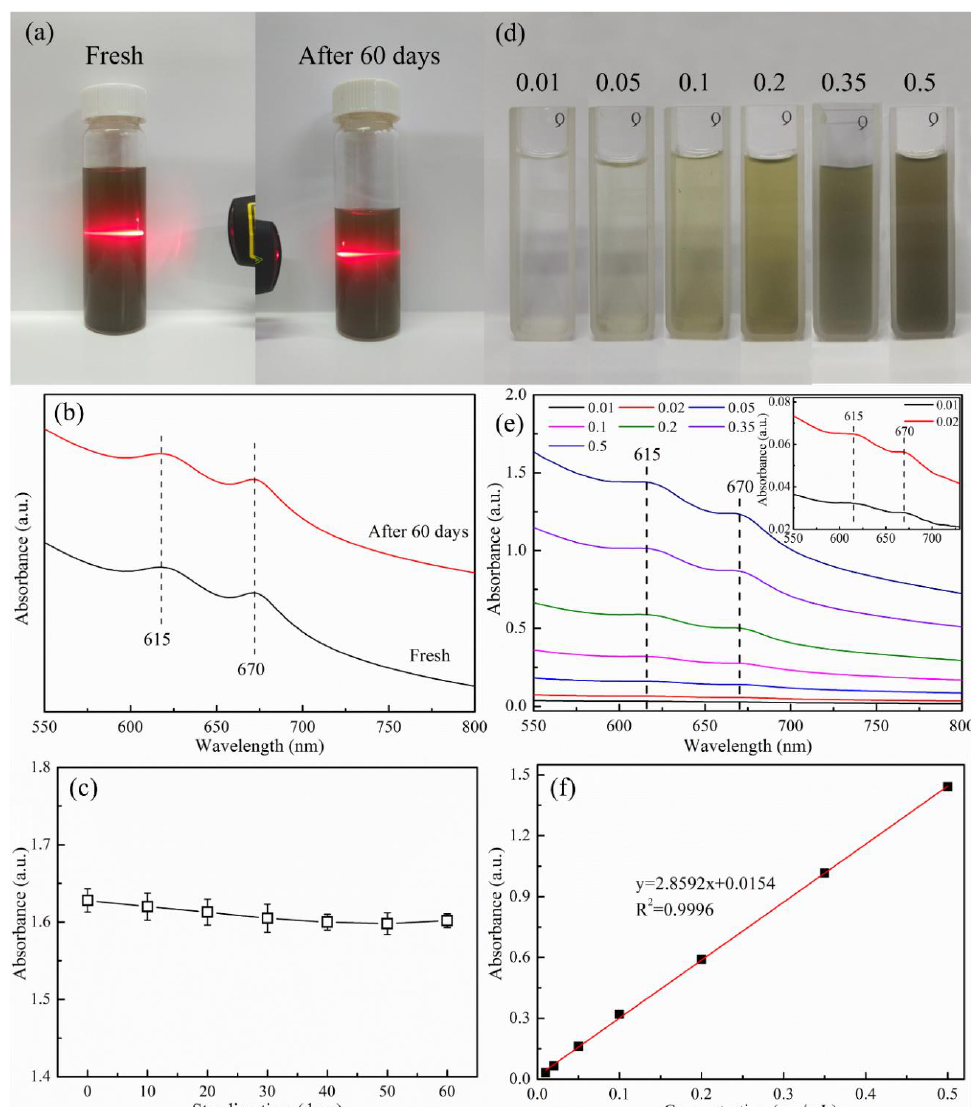
Figure 5. Photographs ( a ), UV-vis absorption spectra ( b ), absorbance change with standing time ( c ) of the prepared MoS 2 NS dispersions and photographs ( d ), UV-vis absorption spectra ( e ) and standard curve ( f ) of MoS 2 NS dispersion in di ff erent